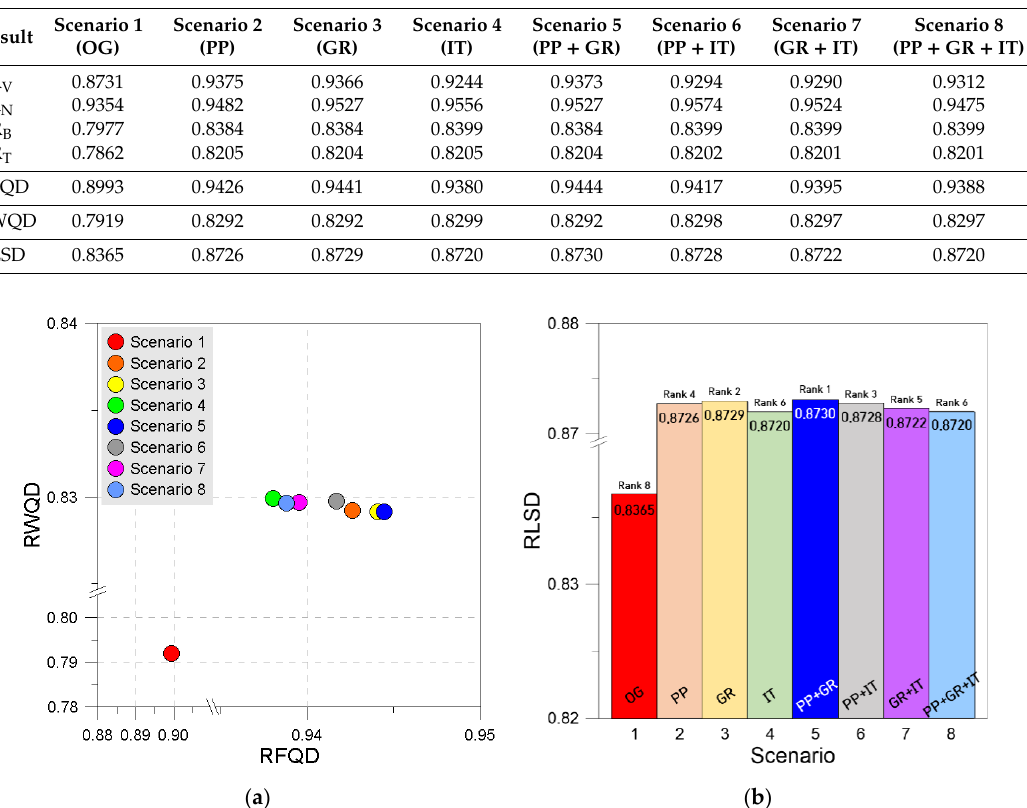
Figure 7. Result of reliability graph based on LID scenarios: ( a ) Reliability result points as a group of symbols scattered; ( b ) Reliability result points as a series of vertical